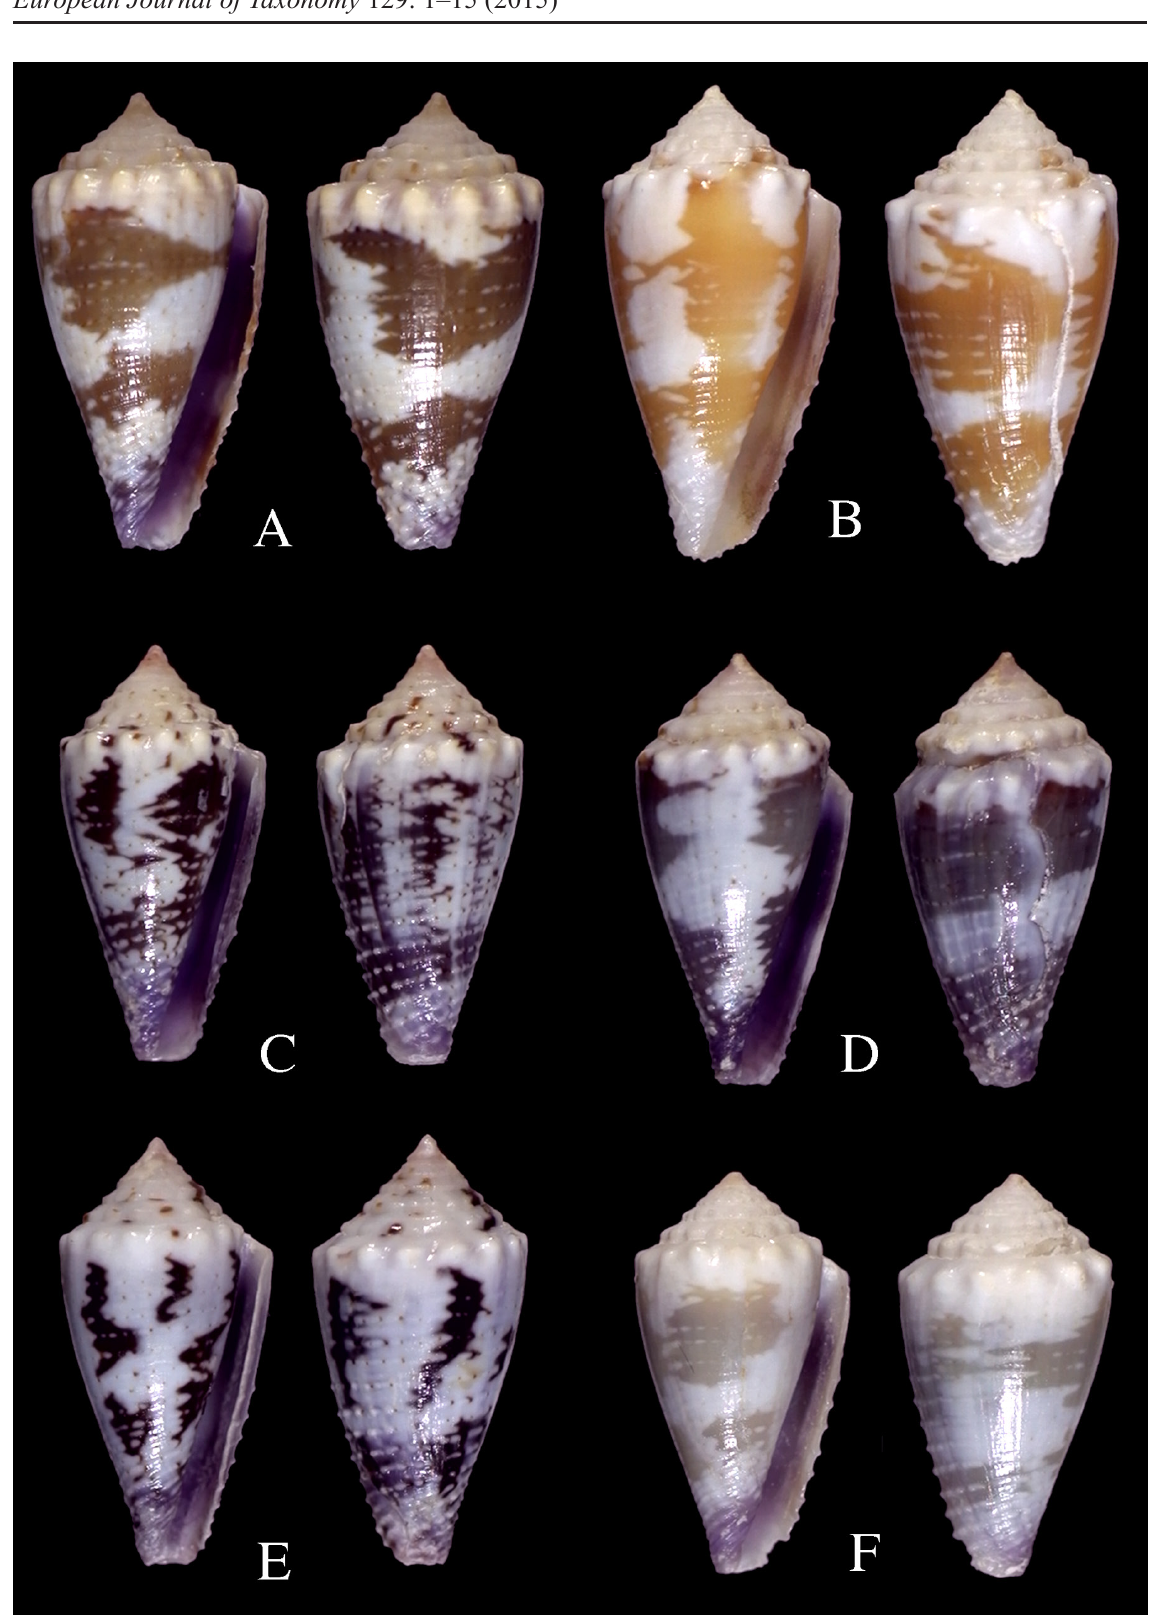
Fig. 4. Conus hughmorrisoni sp. nov. A . Paratype 6, 20.8 mm. B . Paratype 7, 21.6 mm. C . Paratype 8, 19.0 mm. D . Paratype 9, 19.1 mm. E . Paratype 10, 19.6 mm. F . Paratype 11, 18.3